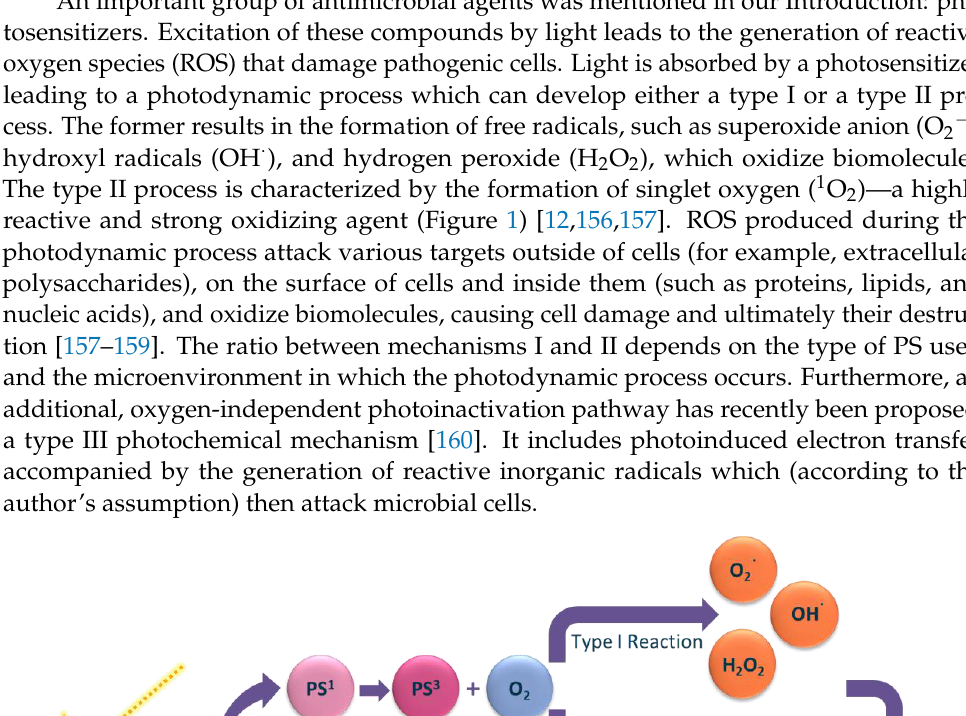
newed in studying the antibacterial properties of PSs [164,165]. Since then, many